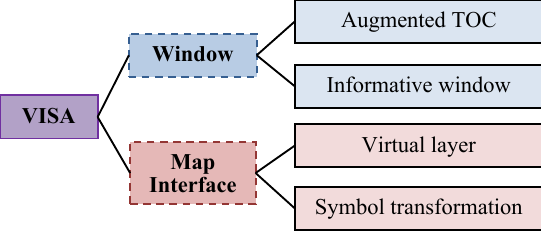
Figure 3. Two categories of VISA